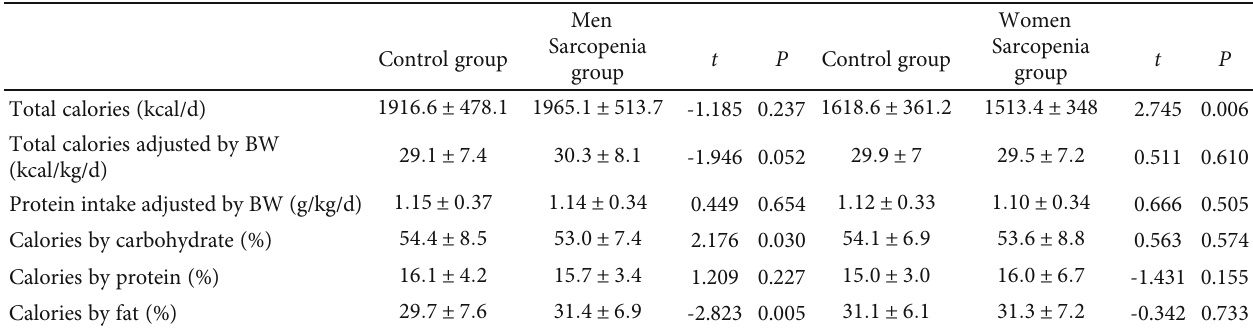
Table 3: Intake of three primary nutrients per day in T2DM participants in the sarcopenia group and control group strati fi ed by sex. Men